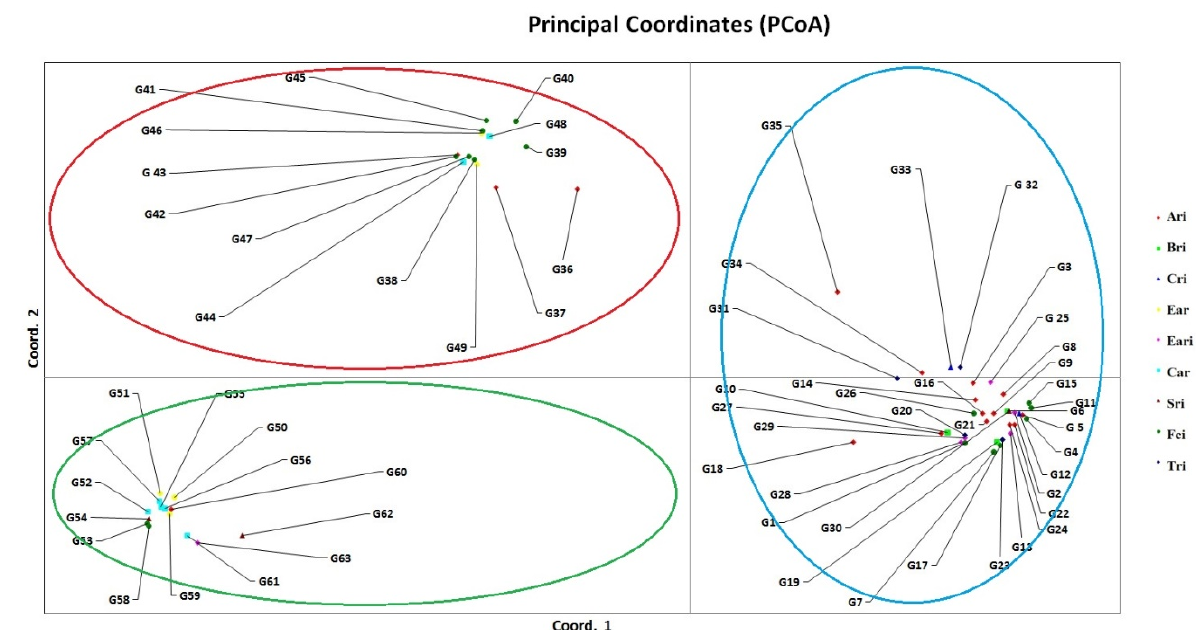
Figure 2. Principal coordinates analysis (PCoA) calculated from the pooled data of thirty-four inter- Primer Binding Site (iPBS) primers in 63 wheat varieties. Ari: Anatolia Agricultural Research Institute,